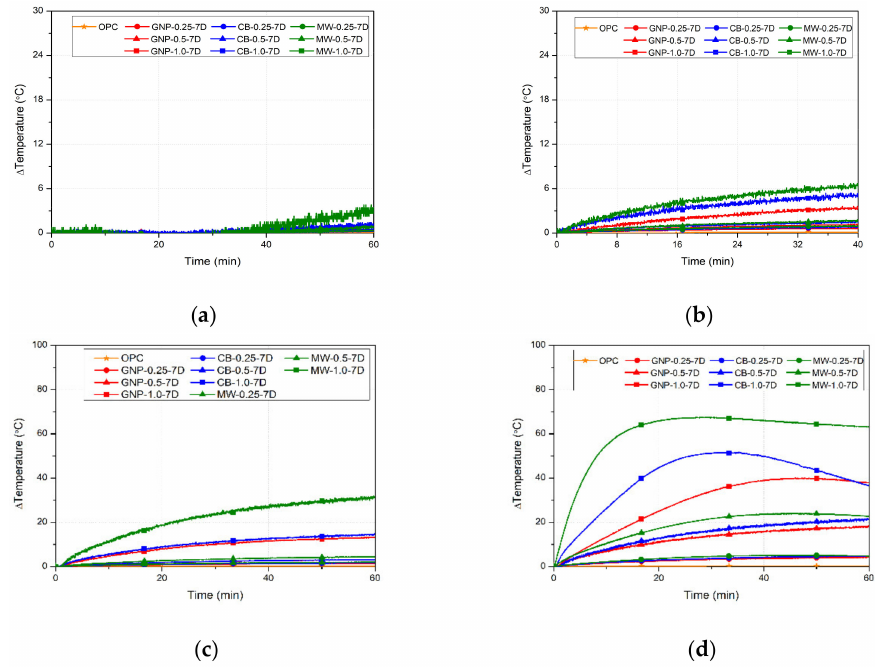
Figure 4. Temperature variation plots of the nanocementitious composites at 7 d at different voltages: ( a ) 10 V; ( b ) 20 V; ( c ) 30 V; ( d ) 60